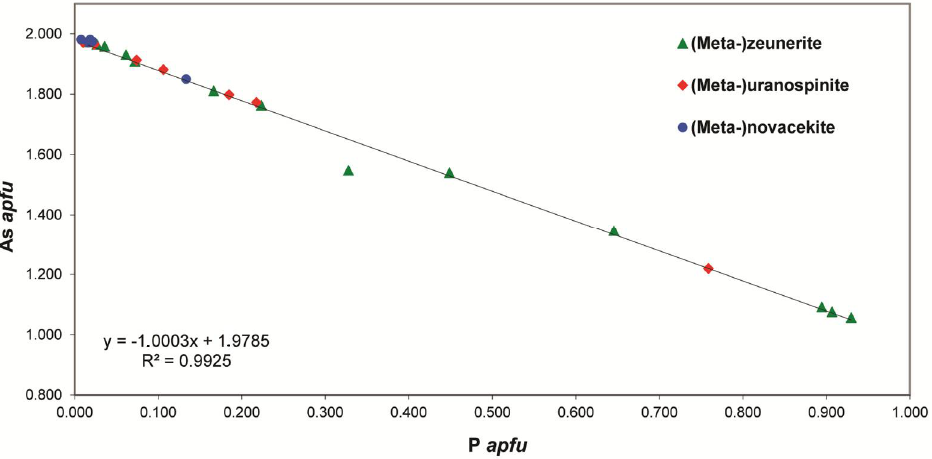
Figure 3. Binary plot of the As content versus the P content of Cu-, Ca-, and Mg-bearing arsenates members of the (meta-)autunite group from Rabejac.